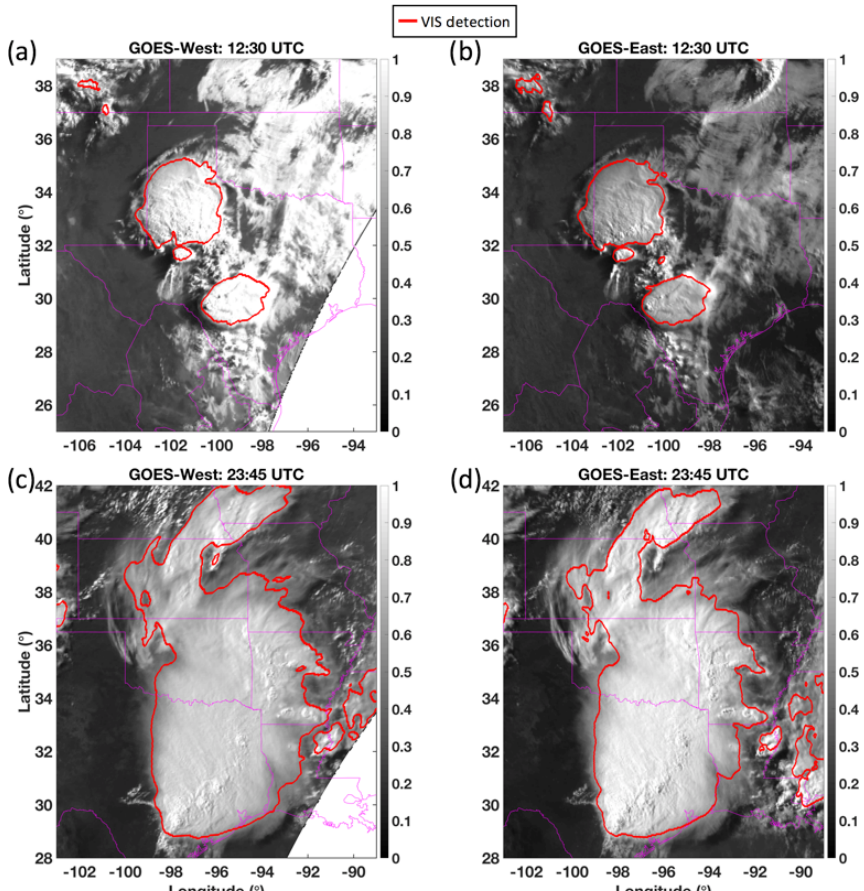
Figure 10. Same as Fig. 1 except with the GOES-West or GOES-East VIS anvil mask outlined in red. The masks from each satellite are similar at the corresponding times despite extreme viewing and illumination